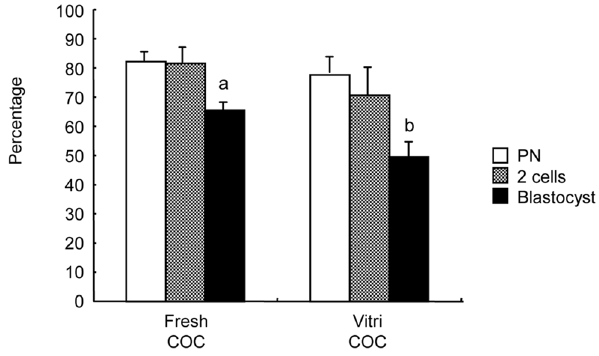
Fig. 1. The effects of cumulus cells on the fertility and developmental ability of C57BL/6J mouse oocytes after IVF. Data are means 6 S.E.M. a-b,c-d,e-f Different superscripts denote a significant difference ( P , 0.05). In each treatment group, more than 100 oocytes were examined. PN, pronuclear stage; COC, cumulus oocyte complexes; DO, denuded oocytes.